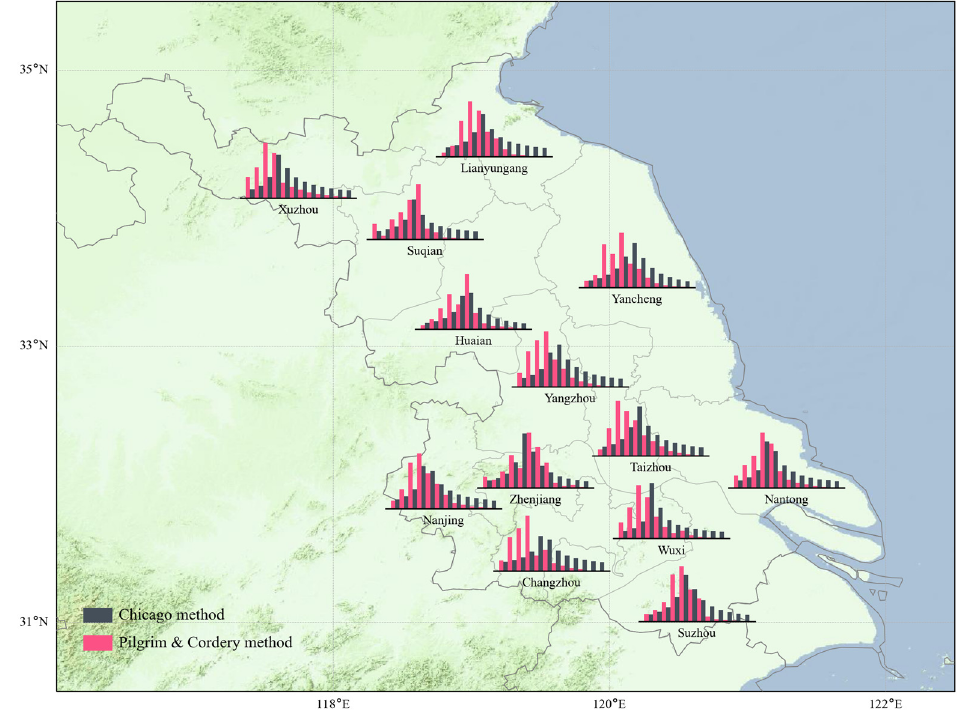
Figure 14. The patterns of 60 min rainstorms in 13 cities designed using PC method and Chicago method.